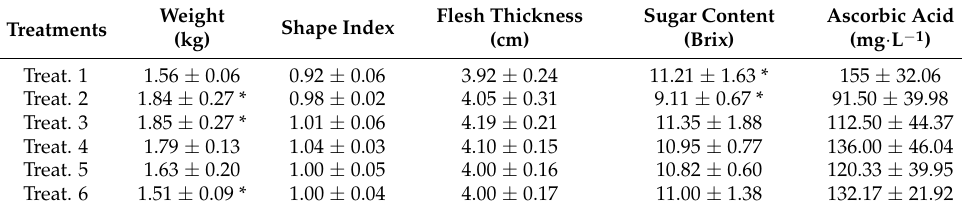
Table 2. The change in fruit weight and quality ( n = 6) among different nutrient treatments. * p <